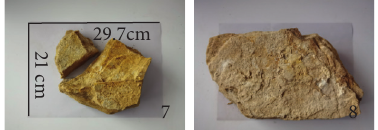
Figure 7: Outcrop of secondary weak structure C.